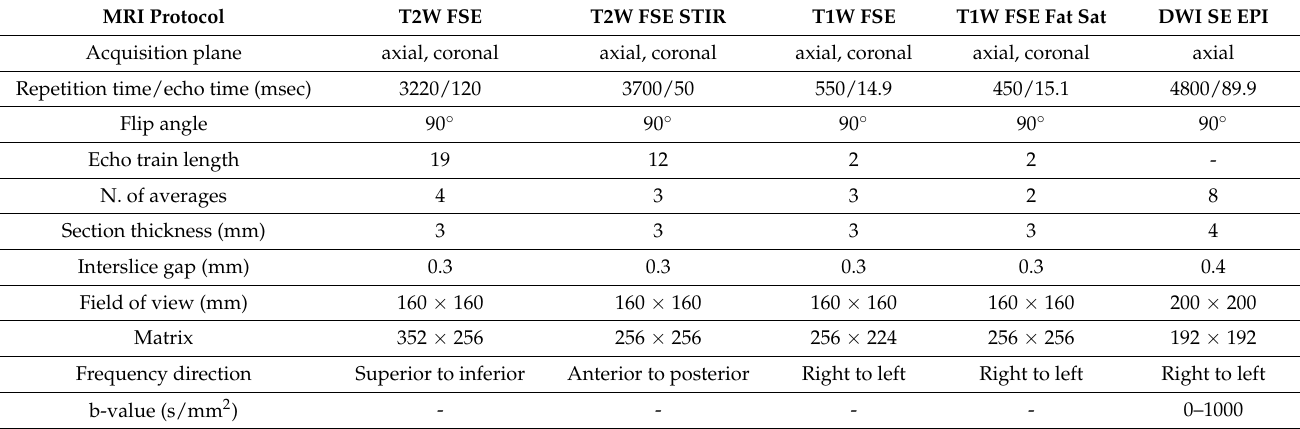
Table 1. MRI protocol. Table sets out an overview of parameters of MRI pulse sequences. Fat- suppressed T1-weighted sequences were performed before and after i.v. administration of paramag- netic Gd-based contrast agent (0.2 mL per kilogram of body